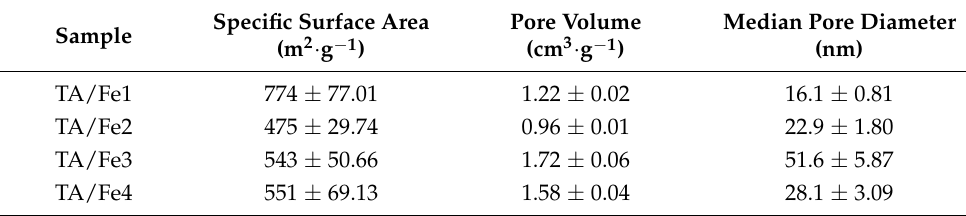
Figure 4. ( a ) N 2 adsorption/desorption curves and ( b ) pore size distribution of the TA/Fe1, TA/Fe2, TA/Fe3, and TA/Fe4. Table 1. Pore structure parameters of the as ‐ prepared aerogel catalysts.